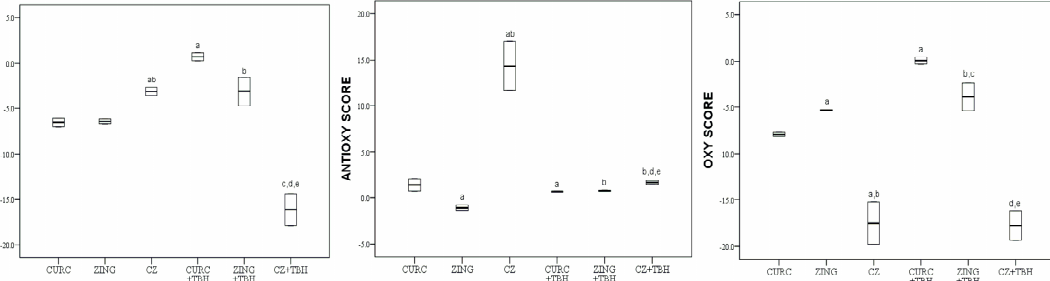
Figure 7. Values of pro-oxidative, antioxidative and oxidative scores of curcumin (CURC), zingerone (ZING) and an equimolar mixture of curcumin and zingerone (CZ) in serum pool before and after the addition of TBH; Values are represented by median (horizontal line) and interquartile range (25–75th percentile (lower and upper edge, respectively)). a,b,c,d,e—significant difference ( p < 0.05) compared to CURC, ZING, CZ, CURC + TBH, ZING + TBH, respectively .